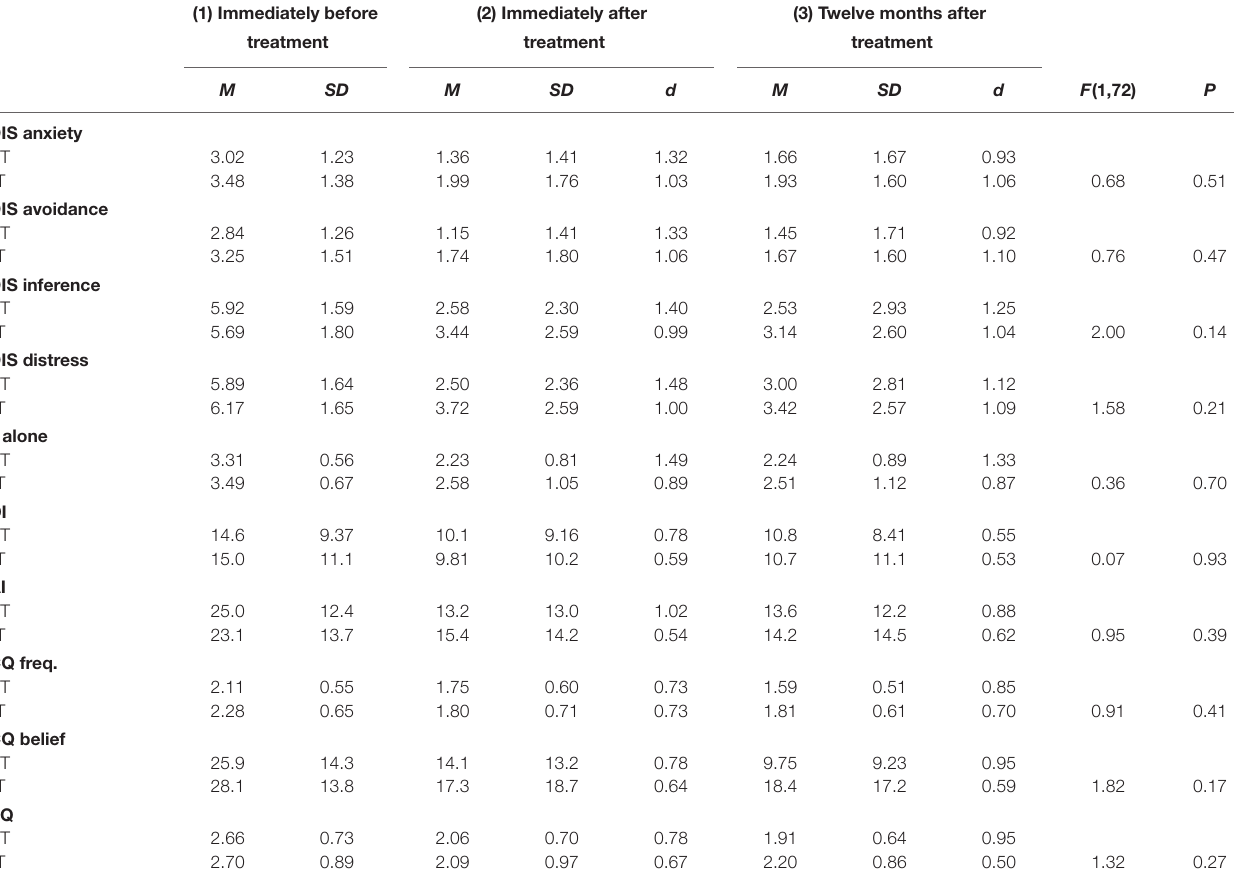
TABLE 4 | Means and standard deviations for patients treated with CBT ( n = 36) or TFT ( n = 36), measured: (1) immediately before treatment; (2) after treatment; (3) 12 months after treatment. (1) Immediately before (2) Immediately after (3) Twelve months after treatment treatment